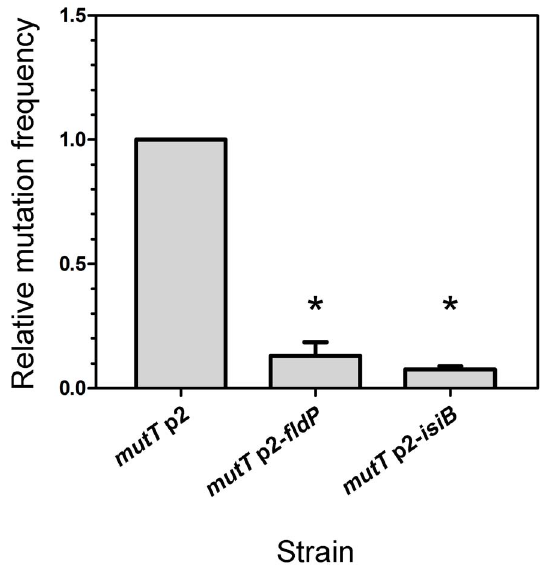
Figure 5. FldP decreases the H 2 O 2 -induced mutation frequency in mutT -deficient P.aeruginosa . The mutT mutant strain transformed with the empty vector p2 was tested for its frequency of mutations induced by H 2 O 2 (50 mM, 30 min), and compared with mutT mutants expressing fldP or isiB . The H 2 O 2 -induced mutation frequency was calculated as the ratio between the number of streptomycin-resistant cells and the number of viable cells and normalized to 1 in the mutT strain. The experiments were carried out in quintuplicate for three independent replicas, and the results were expressed as means 6 SEM. Statistically significant differences ( P , 0.05) are identified by * (one- tailed Mann-Whitney test).